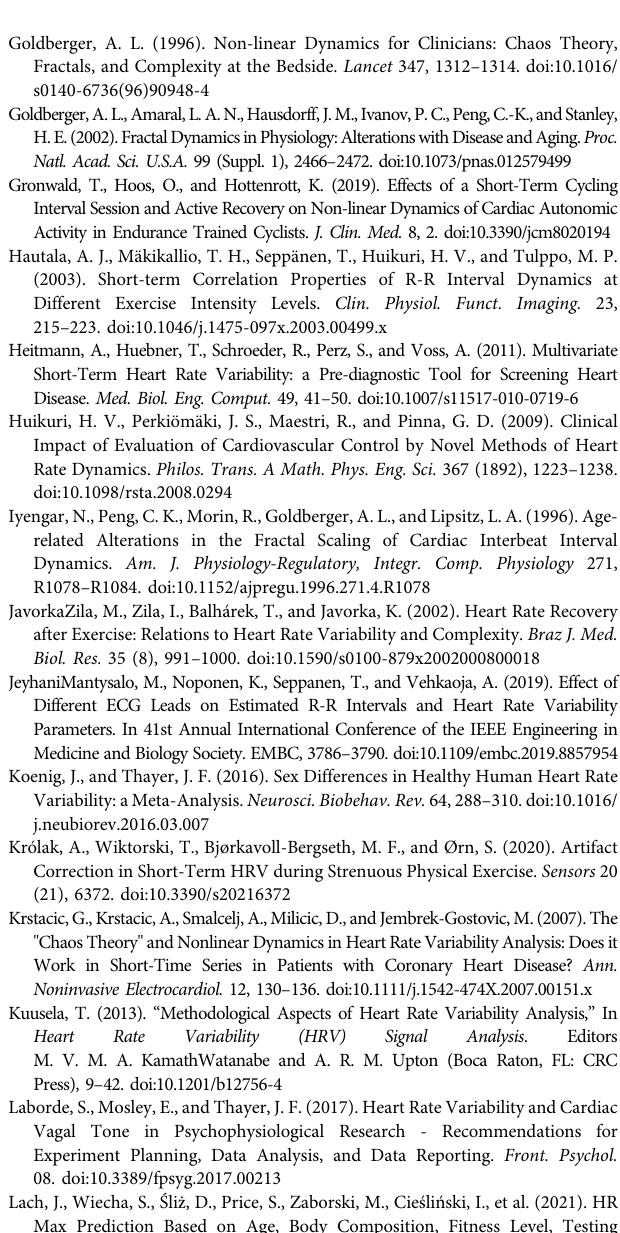
Supplementary Table S5 | DFA α 1 two-minute comparison in Phase II participants. p -values are reported in comparison with previous activity. All numbers except p -values are presented as mean